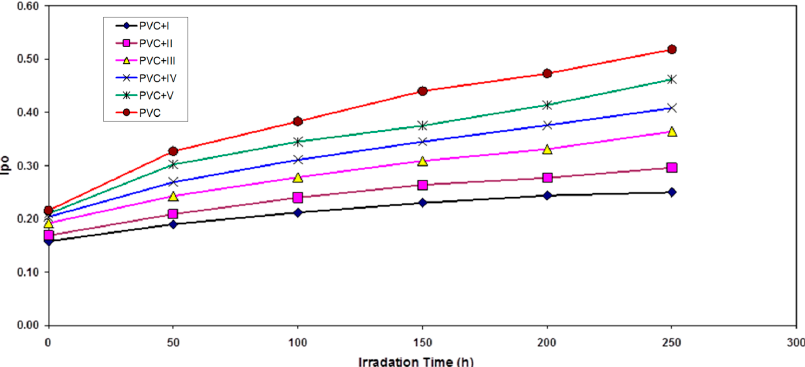
Figure 2. The relationship between the carbonyl index and irradiation time for PVC films (30- µ m thickness) containing different additives. The concentration of additives is fixed at 0.5% by weight.